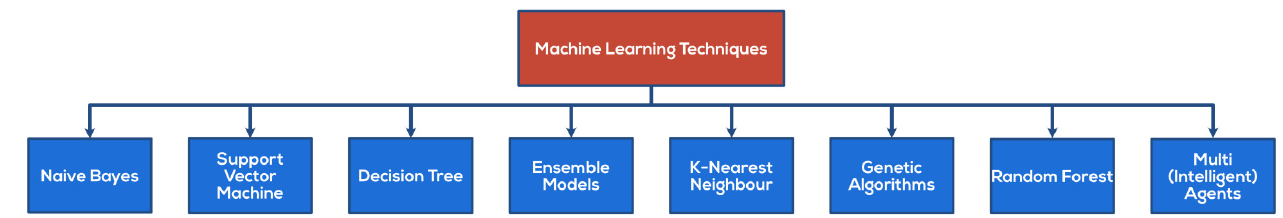
Figure 2. Current machine learning models in defensive deception—nomenclature.